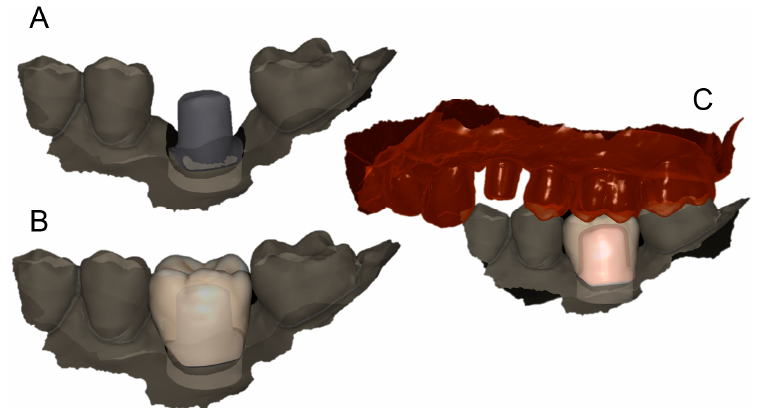
Figure 12. Second CAD scene (PLAN2) with the design of the final restoration. ( A ) the margine line of the individual hybrid abutment is clearly visible, even if subgingival; ( B ) since the margin line is clearly visible and automatically detected by the software, the dental technician can design the final restoration; ( C ) lateral view with detail of occlusion.